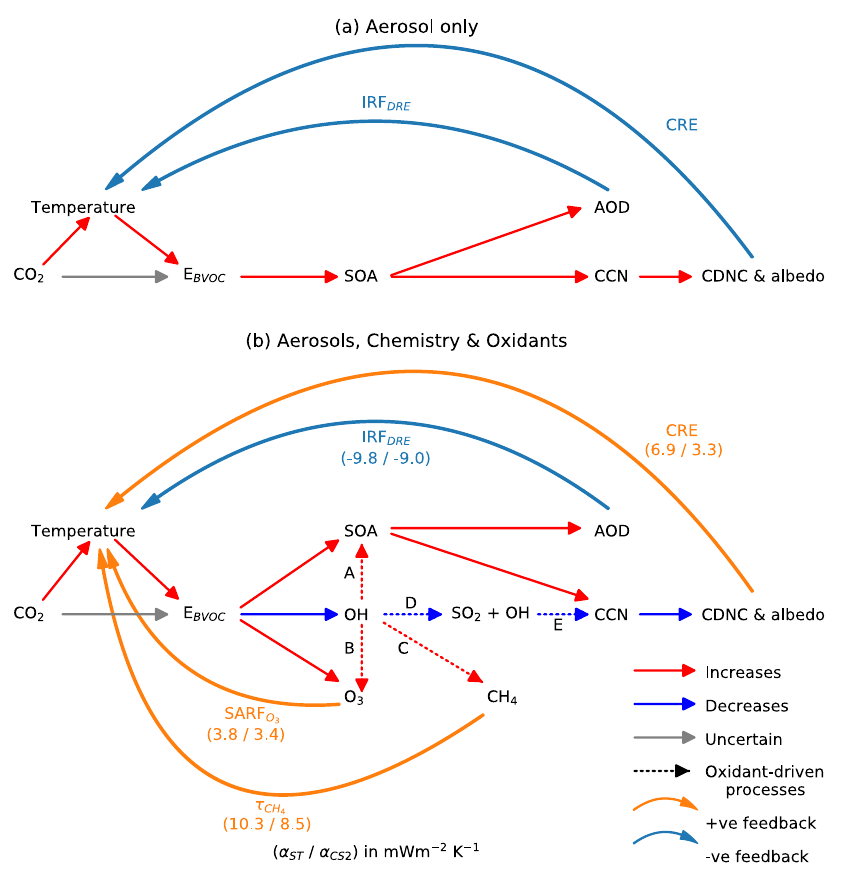
Fig. 5 | Atmospheric composition response and BVOC feedback from an increase in CO 2 driving an increase in BVOC emissions (E BVOC ). In ( a ) only aerosols are considered yielding a negative feedback (adapted from 23 ) whereas in ( b )chemistryandoxidantsarealsoallowedtorespond,leadingtoamorecomplex response. Aerosol optical depth (AOD) is a measure of aerosol scattering while IRF DRE and CRE correspond to the forcing from changes to the aerosol direct radiative effect and aerosol cloud interactions respectively. Dashed lines in ( b ) show important oxidant-driven responses including reduced OH driving (A)